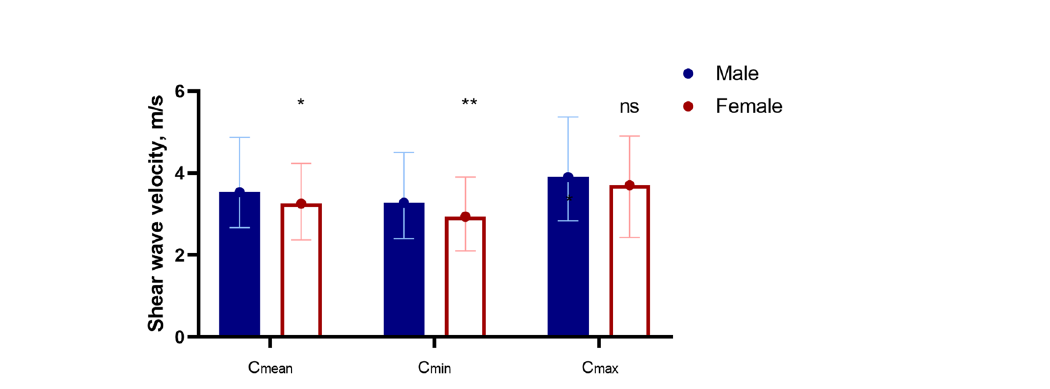
Figure 5. Comparison of shear wave velocities in relation to gender. *Means p < 0.05, and **means p < 0.01.ns means not significant.